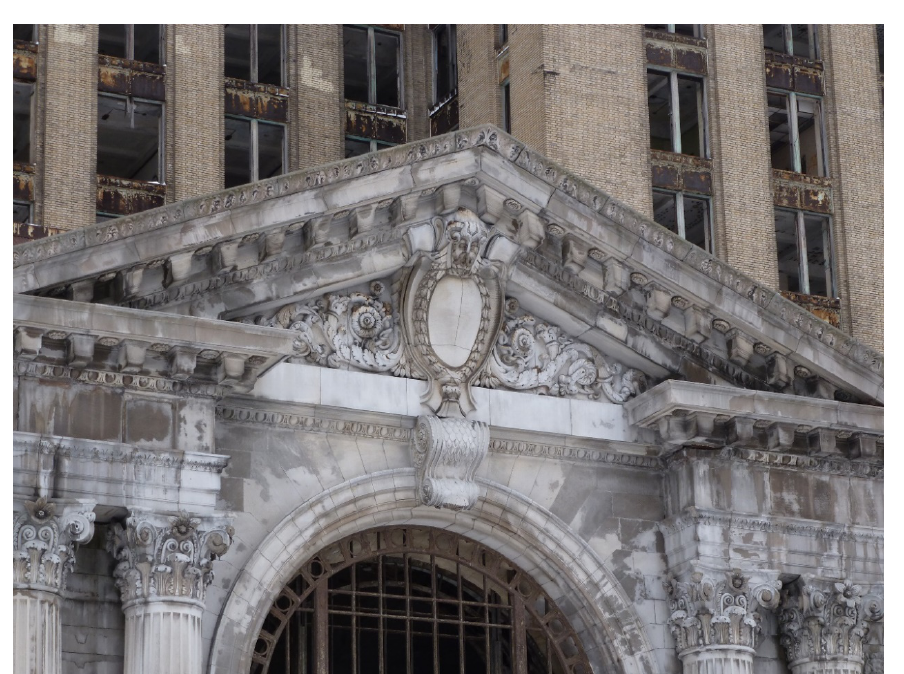
Figure 4. Michigan Central Depot in Detroit, Michigan (Photo courtesy of Ball State University undergraduate architecture student Jordan